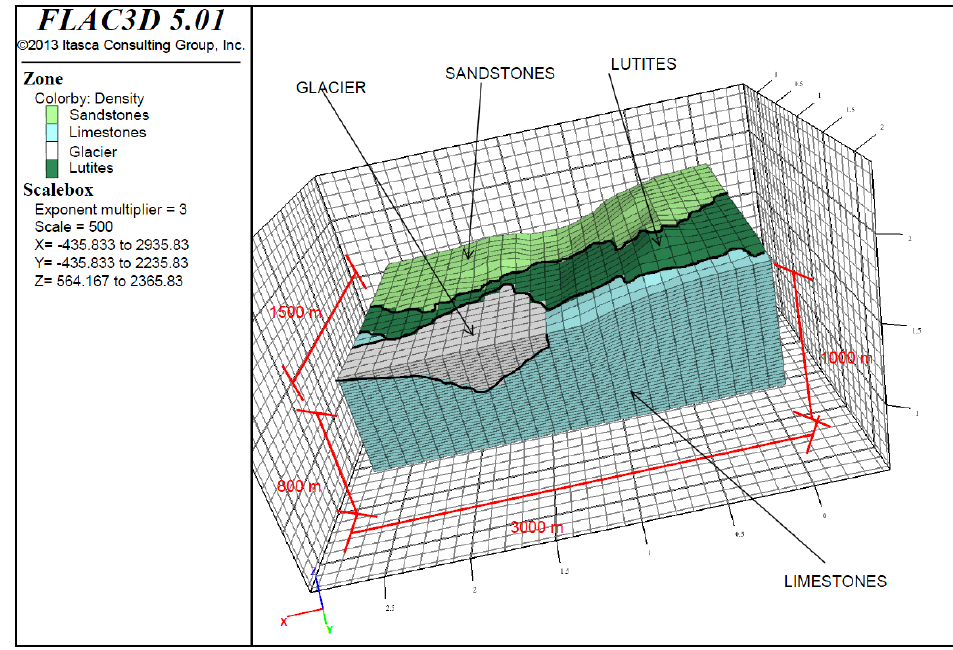
Figure 6. Initial geometry considered for the 3D simulation.